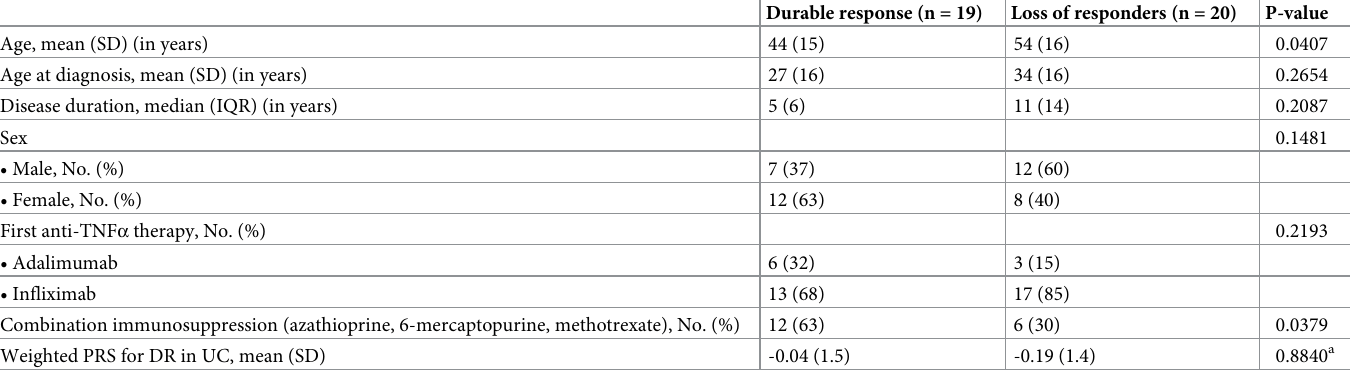
Table 4. Comparison of characteristics of patients with ulcerative colitis exposed to anti-tumour necrosis factor alpha therapy with durable response and loss of